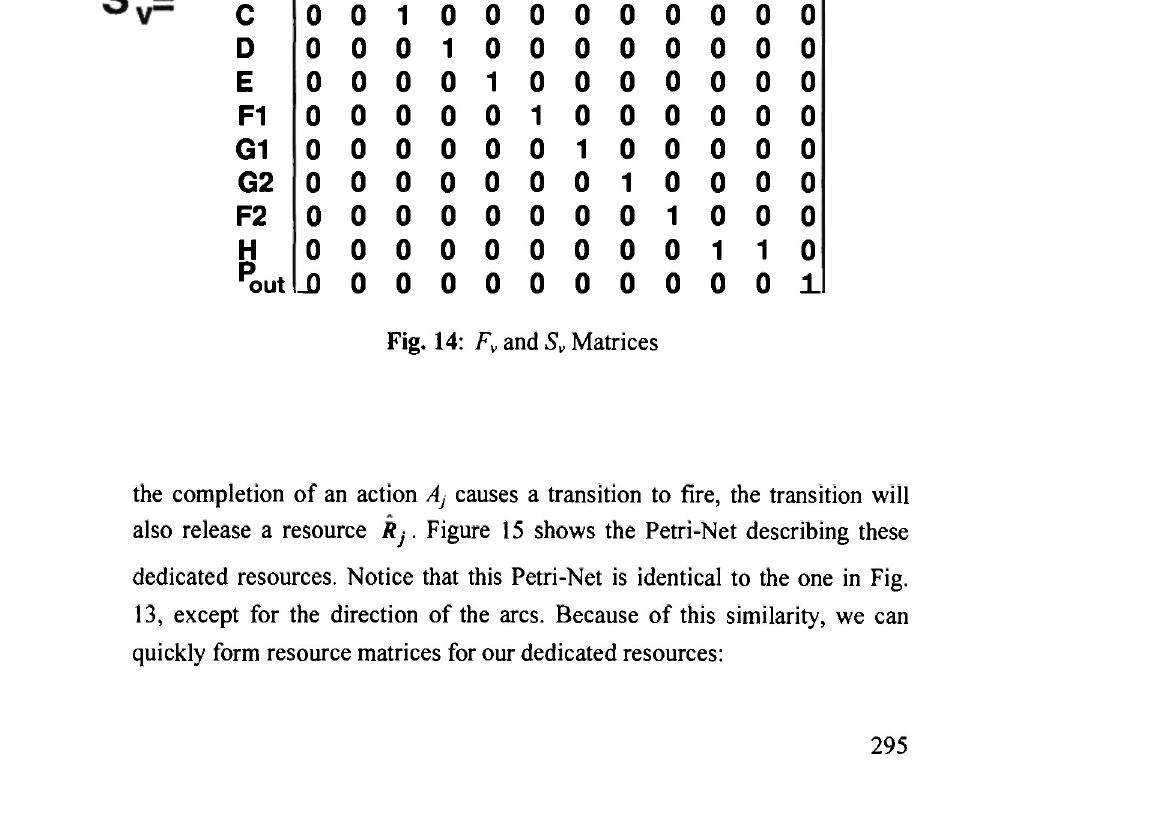
Fig. 14: F v and S v